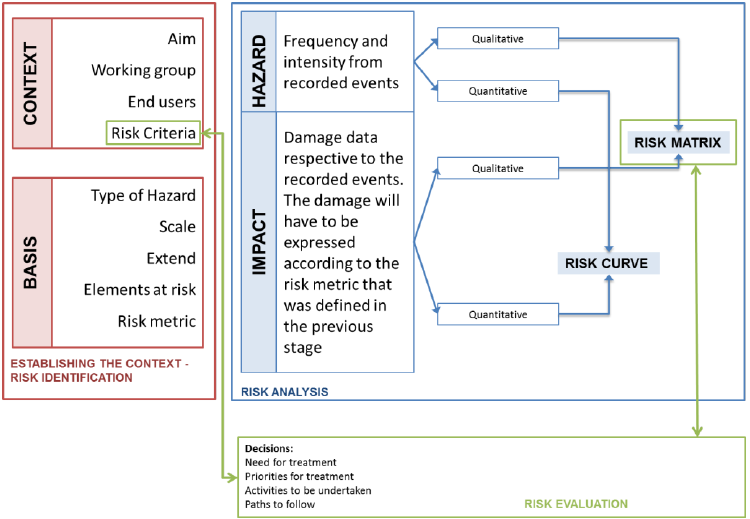
Figure 2. The structure of the Common Risk Assessment Methodology and the three parts of risk assessment (risk identification, risk analysis, and risk evaluation) [46].